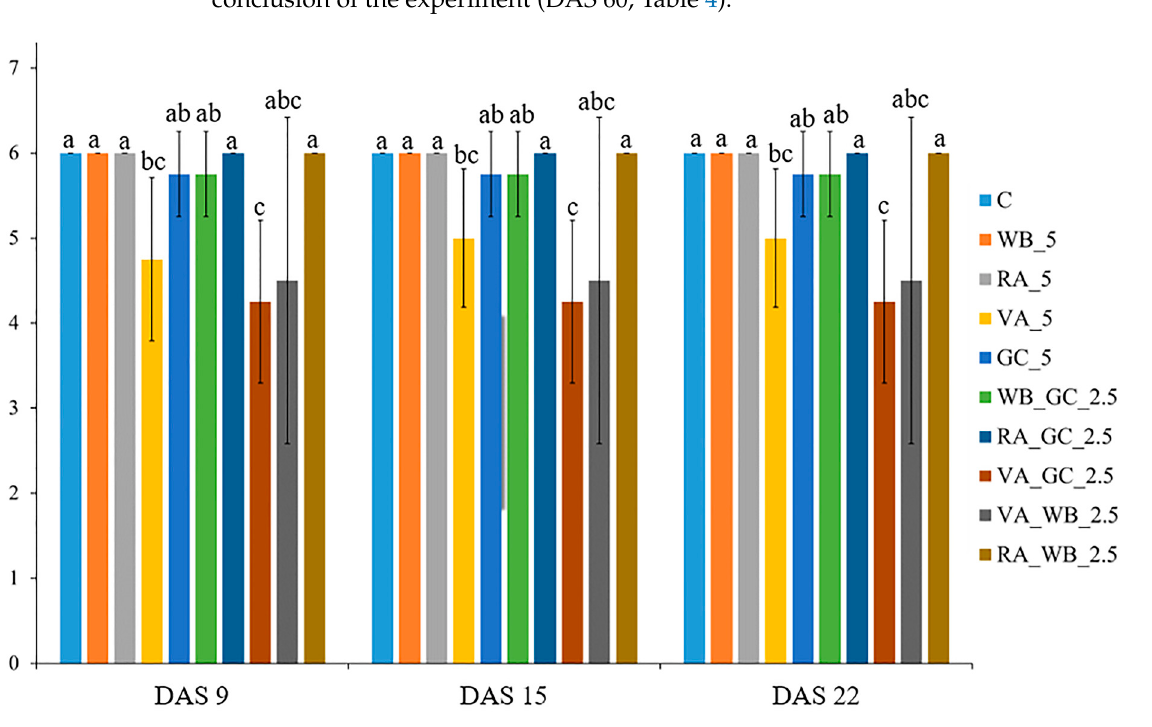
Figure 2. Average number of germinated seeds per pot up to 22 DAS. (means n = 4 ± standard error). Di ff erent le tt ers indicate signi fi cant di ff erences between treatments ( p < 0.05).